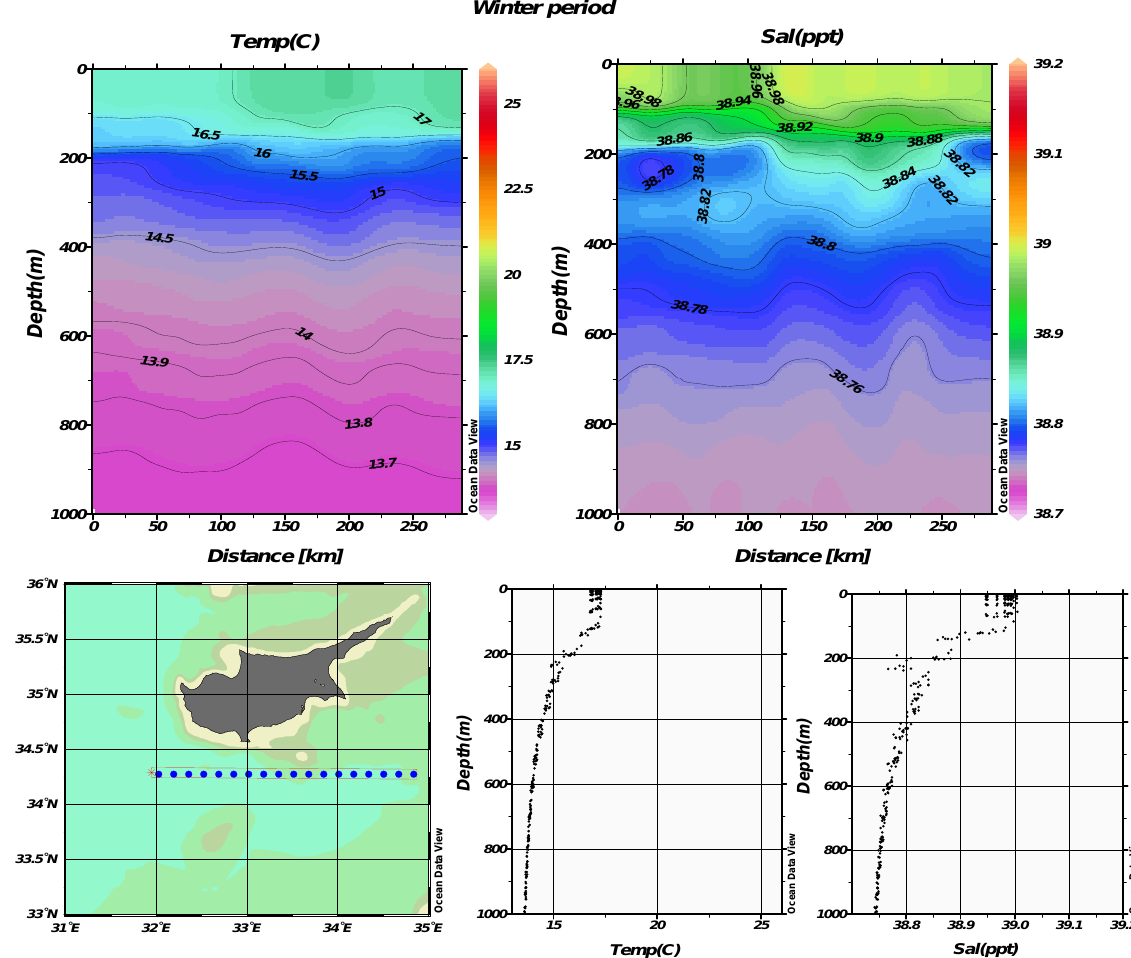
ODV5.5: C:\VOS\POM10201; C:\VOS\pom10201.cfg; C:\VOS\.sec - Jun/18/2002 08:46:28 Fig. 8a. CYCOM temperature and salinity vertical structure and their composite profiles along the east-west section south of Cyprus, winter period of the second year of the climatological